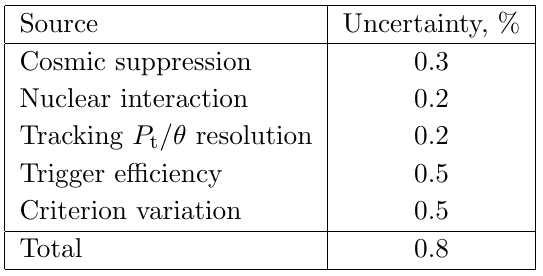
Table 6 . Sources of detector-related systematic uncertainties in